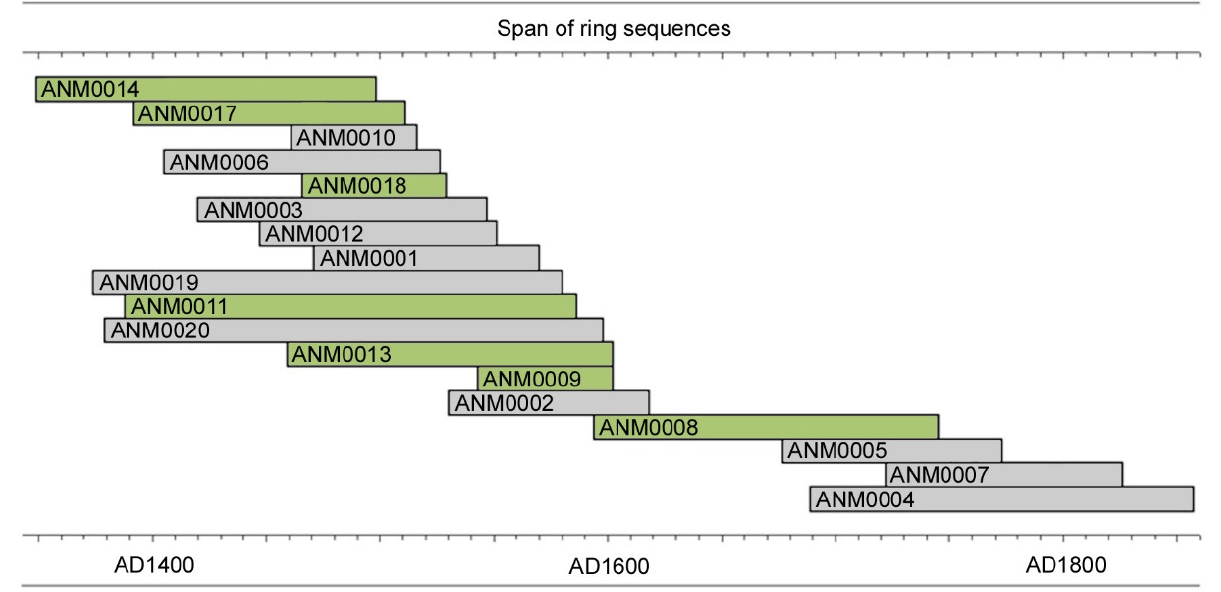
Figure 8. Chronological span of dated pine timbers (Bosnian pine in green, Black pine in gray) from the Monastery of St. Nicholas. Graph was prepared in DENDRO for Windows [50].